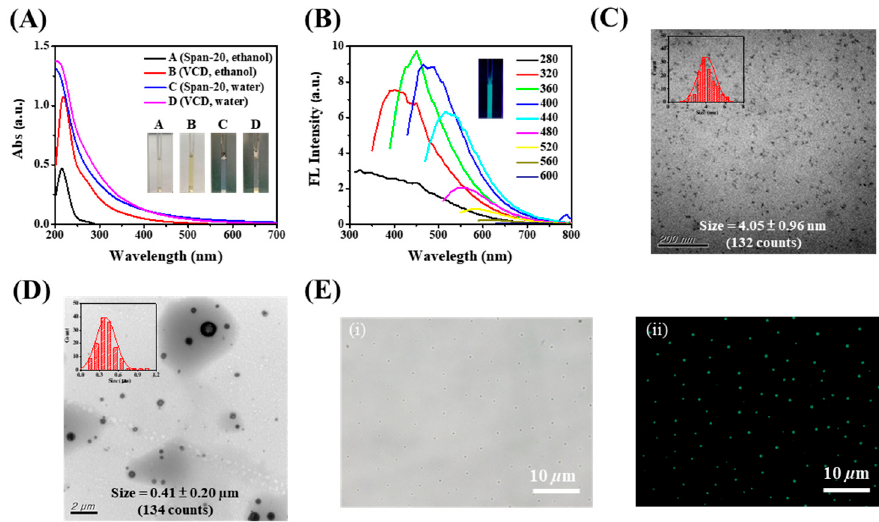
Figure 1. ( A ) UV–visible absorption spectra of 0.5 mg/mL span-20 (spectra A, C) and VCDs (spectra B, D) in ethanol (spectra A, B) and aqueous (spectra C, D) systems, respectively. Inset photos show span-20 and VCDs in a different environment. ( B ) Effect of excitation wavelength on the emission behavior of VCDs. The insert photograph displays the VCDs fluorescence observed under a 365 nm UV lamp. TEM images of VCDs suspended in ethanol ( C ) and aqueous solution ( D ), respectively. Insets are the particle-size distribution of the corresponding samples. ( E ) Bright-field (i) and fluo- rescence ( λ ex = 360–370 nm; λ em ≥ 420 nm) microscopic images (ii) of VCDs.